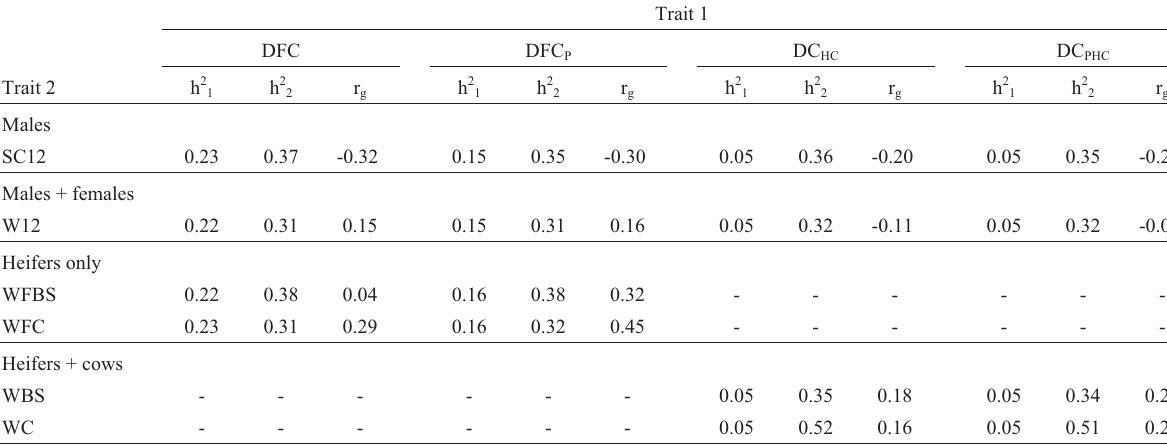
Table3 -Geneticparameterestimatesofdaystofirstcalvingwith(DFC P )andwithout(DFC)penalizationofnon-calvingheifersanddaystocalvingwith (DC PHC ) and without (DC HC ) penalization of non-calving females with scrotal circumference at 12 months of age (SC12), weight of males and females at 12 months of age (W12), weight of heifers at the beginning of the first breeding season (WFBS) and at first calving (WFC), weight of cows at the begin- ning of the breeding season (WBS) and at calving (WC), obtained in two-trait analyses, in a Canchim herd. Heritability of trait 1 (h 2 1 ); Heritability of trait 2 (h 2 2 ); Genetic correlation between traits 1 and 2 (r g